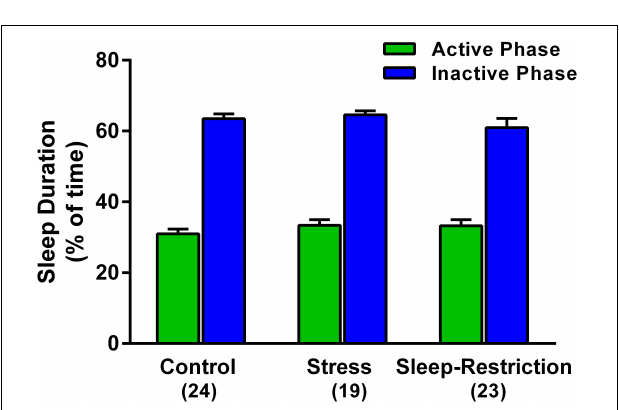
FIGURE 3 | Effects of stress and sleep-restriction conditions on sleep duration in the active and inactive phases of the circadian cycle measured from P74–P77. Bars represent mean ± SEM for the number of mice indicated. Results of ANOVA are given in Table 2